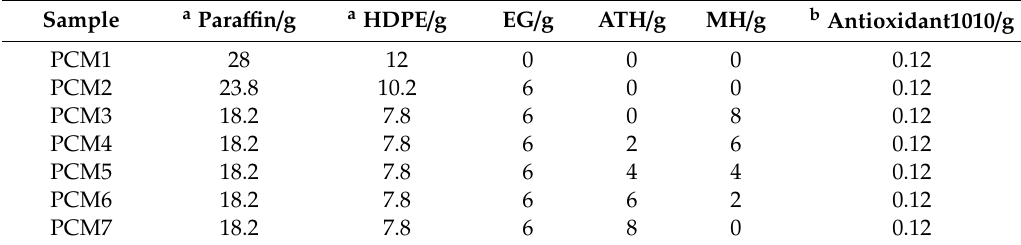
Table 2. Sample compositions used in this study.